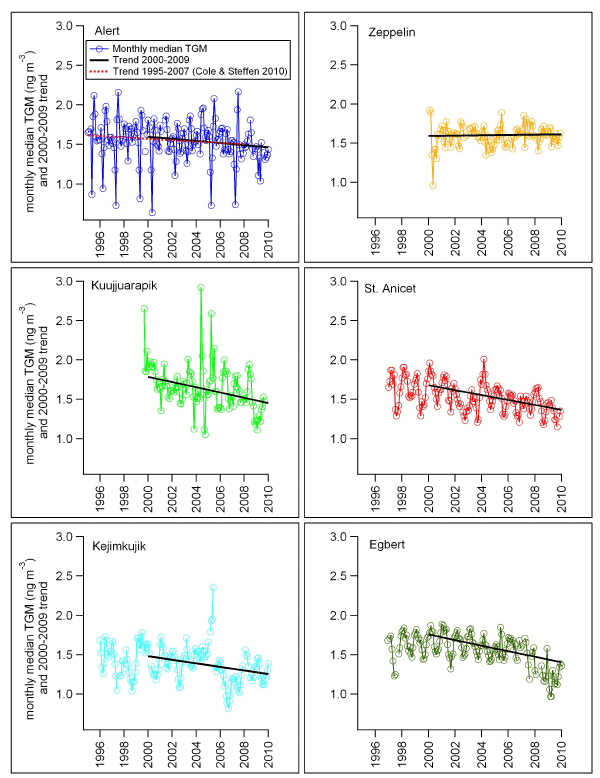
Fig. 4. Time series of monthly median TGM concentrations com- pared to time trends for 2000–2009 calculated from Sen’s estimator of